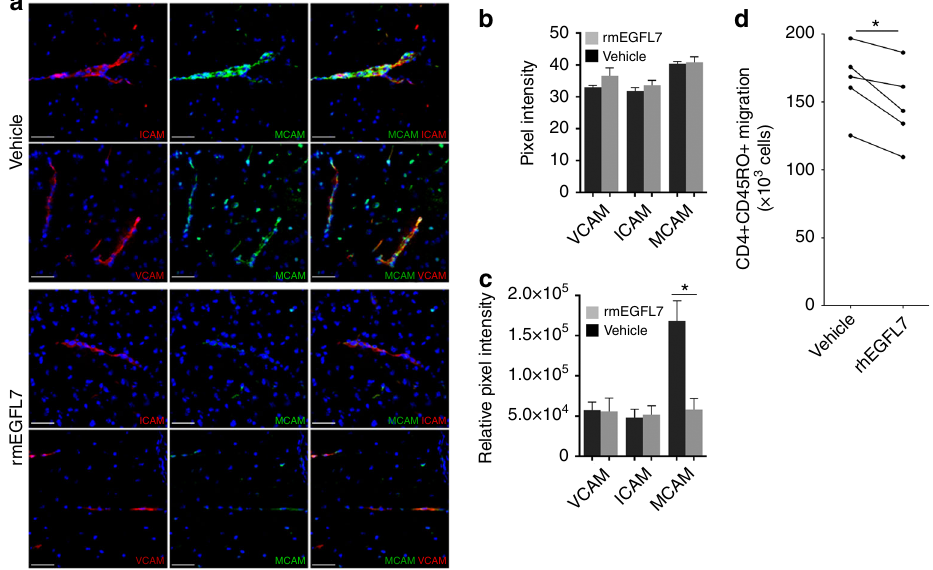
Fig. 5 EGFL7 treatment decreases expression of MCAM by BBB-ECs. a – c Expression of cell adhesion molecules ICAM-1, MCAM, and VCAM-1 was assessed by immuno fl uorescence on frozen sections (cerebellum, brainstem, and spinal cord) from representative EAE mice treated with rmEGFL7 (lower panels, spinal cord) or vehicle (upper panels, spinal cord) as described. Left column: ICAM-1 or VCAM-1 (red), DAPI (blue). Middle column: MCAM (green), DAPI (blue). Right column: merge (yellow). Scale bar = 50 μ m. n ≥ 5 sections/mouse, from n = 5 mice/group. b , c Pixel intensity and relative pixel intensity of ICAM-1, MCAM and VCAM-1 as calculated using ImageJ software. d Number of cells in bottom chamber after 16 h migration over in fl amed human BBB-ECs (modi fi ed Boyden chamber assay), following 24 h exposure to rhEGFL7 10 μ g/ml or vehicle. One million activated CD4CD45RO T lymphocytes were seeded. n = 5 donors, two different preps. Statistical analysis performed by Mann-Whitney U -test ( b , c ) and by Wilcoxon matched-pairs signed rank test ( d ). * p < 0.05. All data presented as mean ± (Abcam; 1:200), rat anti-mouse CD106 (eBioscience; 1:100) and rat anti-mouse CD54 (eBioscience; 1:100). Fluorescence was visualized and acquired in a Leica